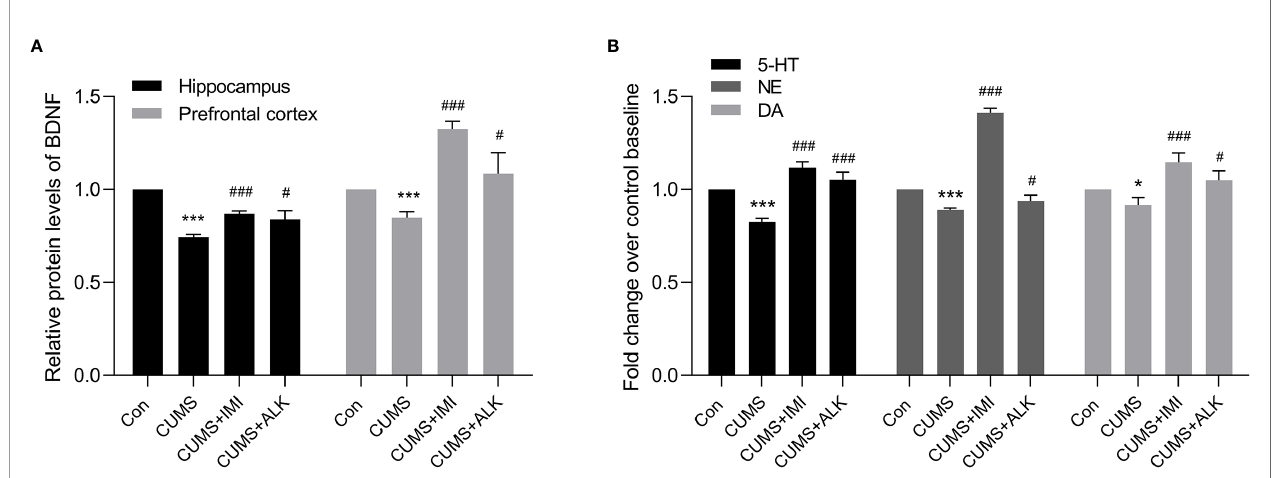
FIGURE 3 | The relative levels of BDNF, 5-HT, NE, and DA. (A) The relative protein levels of BDNF in the hippocampus and prefrontal cortex. (B) The relative monoamine neurotransmitter (5-HT, NE, and DA) levels in serum. Data are presented as the mean ± SD. * P < 0.05, *** P < 0.001 versus the control group (Con); # P < 0.05, ## P < 0.01, ### P < 0.001 versus the CUMS